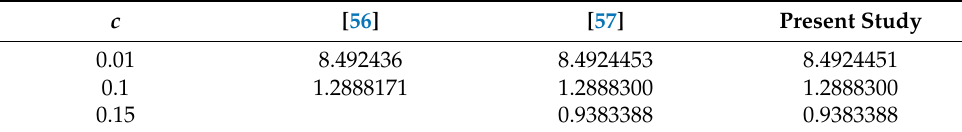
Table 3. Comparison values of f (cid:48)(cid:48) ( c ) when M = λ = ε = ϕ 1 = ϕ 2 = 0 for some thicknesses of needles, c when Pr = 1.